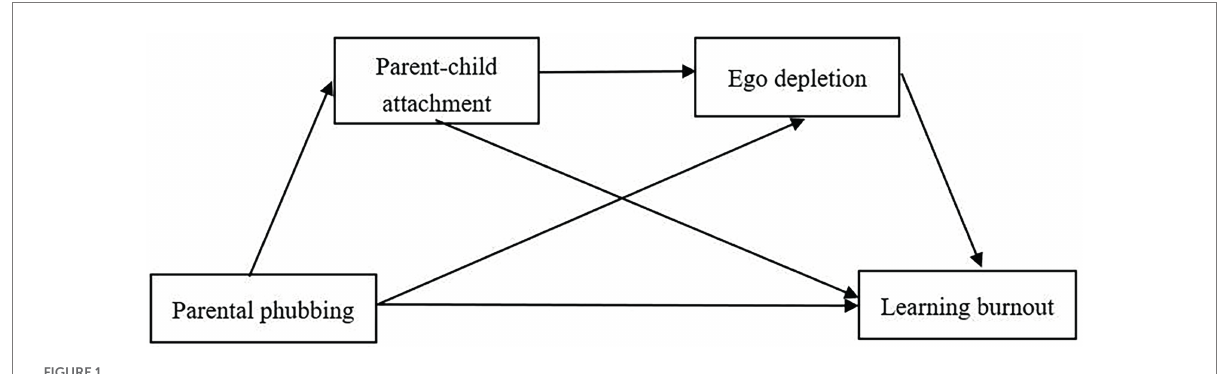
FIGURE 1 The proposed mediation